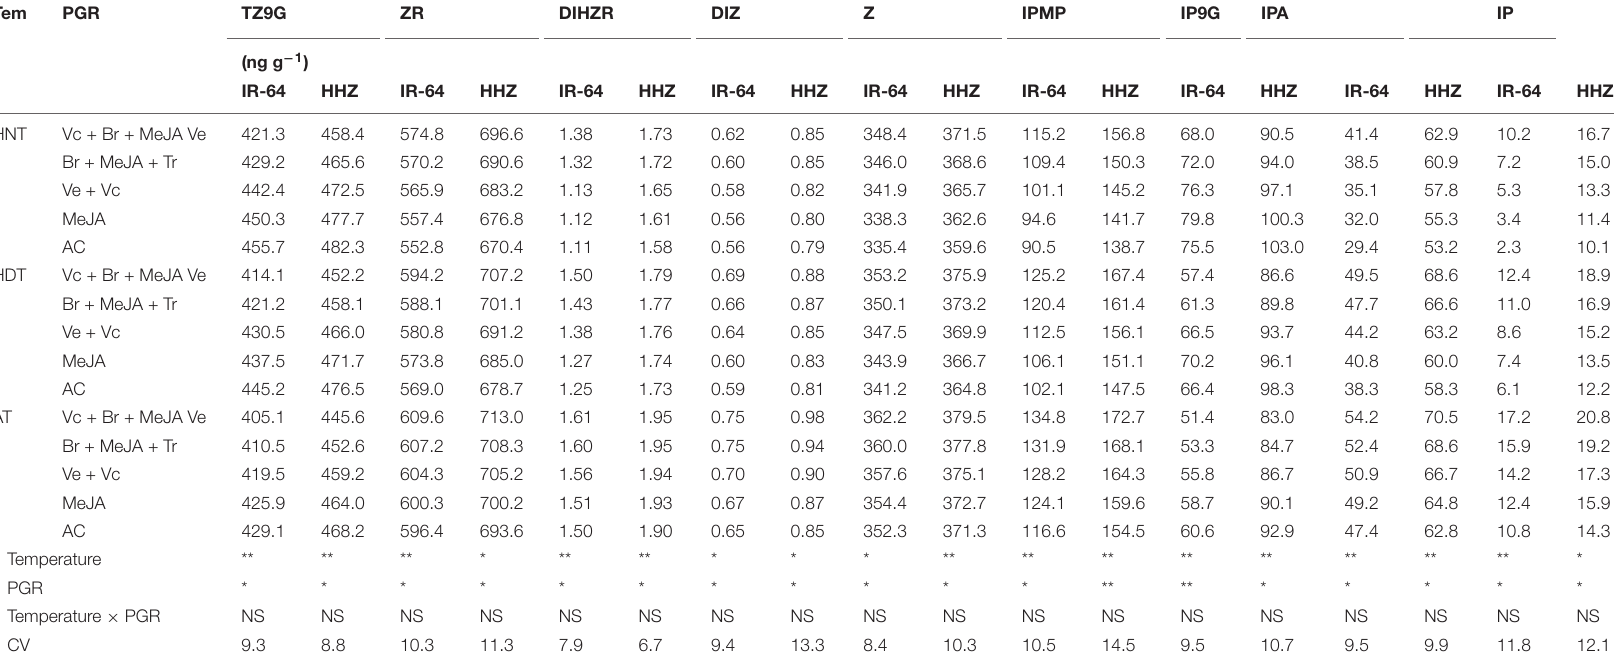
TABLE 4 | Impact of plant growth regulators on hormones content in rice root under heat stress at heading stage. Tem PGR